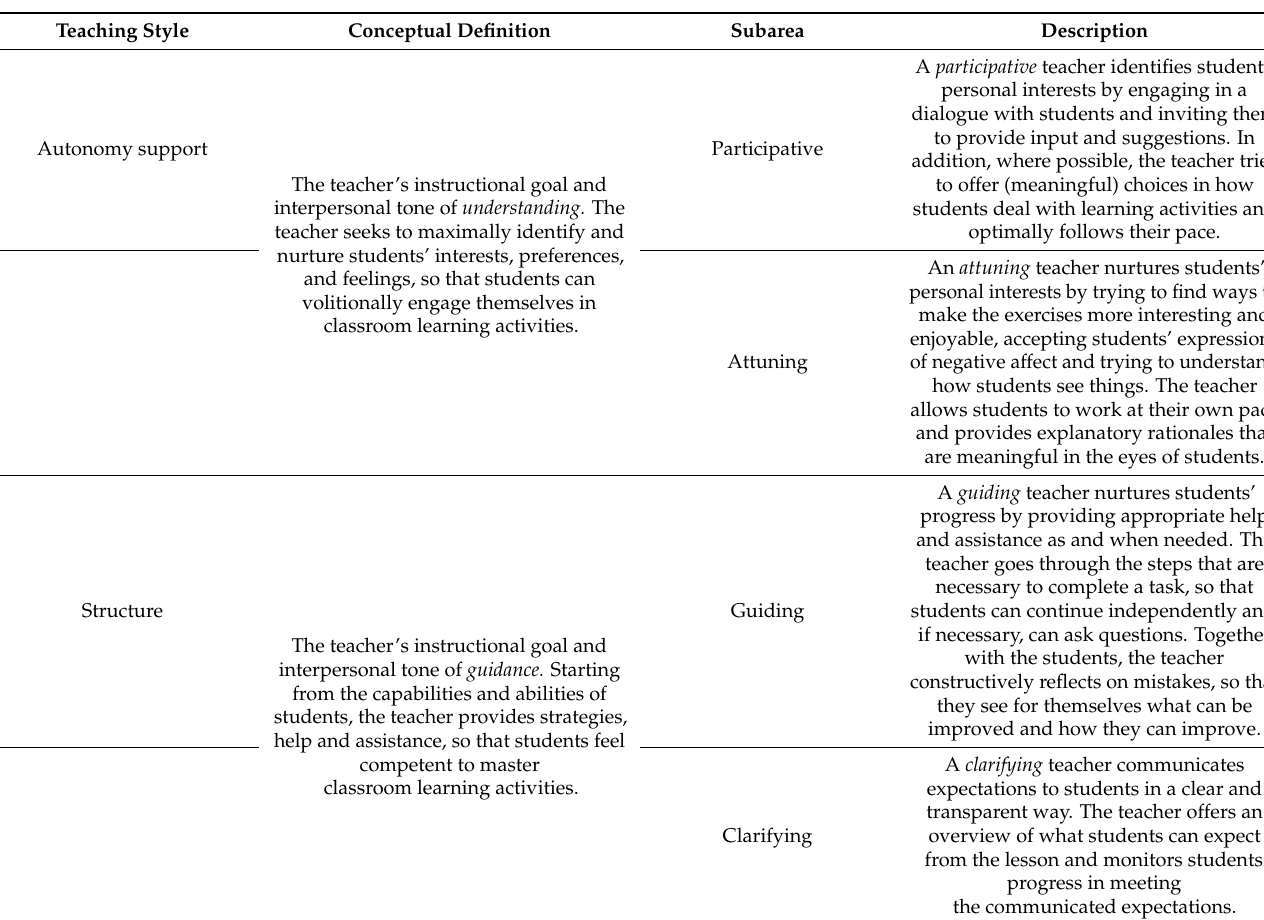
Table 1. Conceptual definitions of the four teaching styles and description of the eight identified teaching approaches (Aelterman et al.,